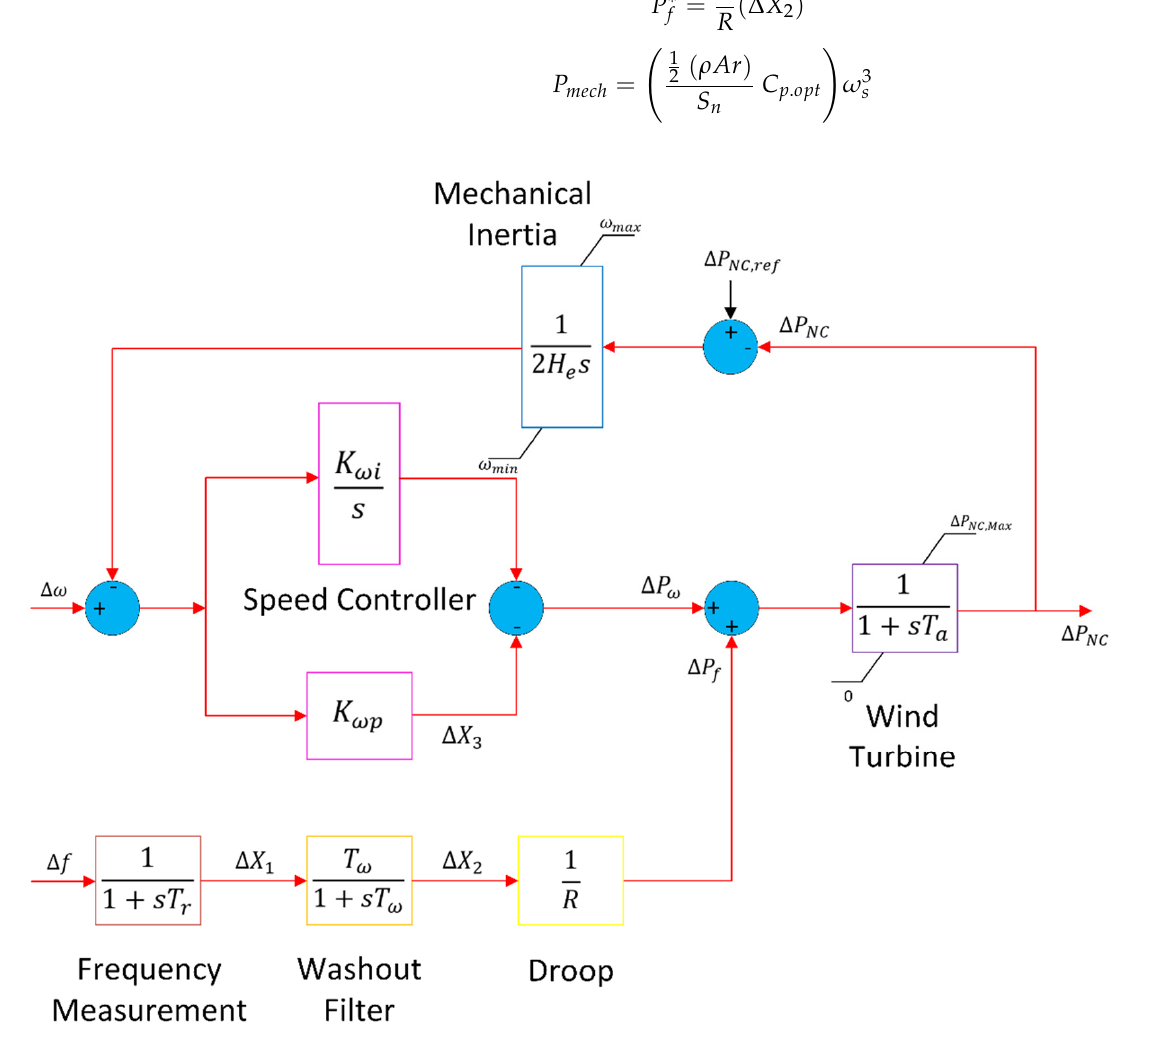
Figure 7. Model of DFIG-based wind turbines with inertia control.